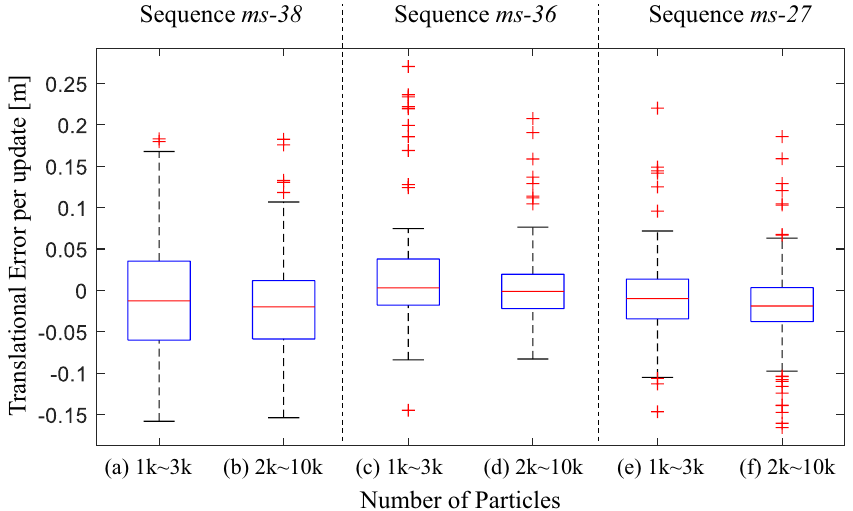
Figure 9. The translational errors in the tests with different amount of